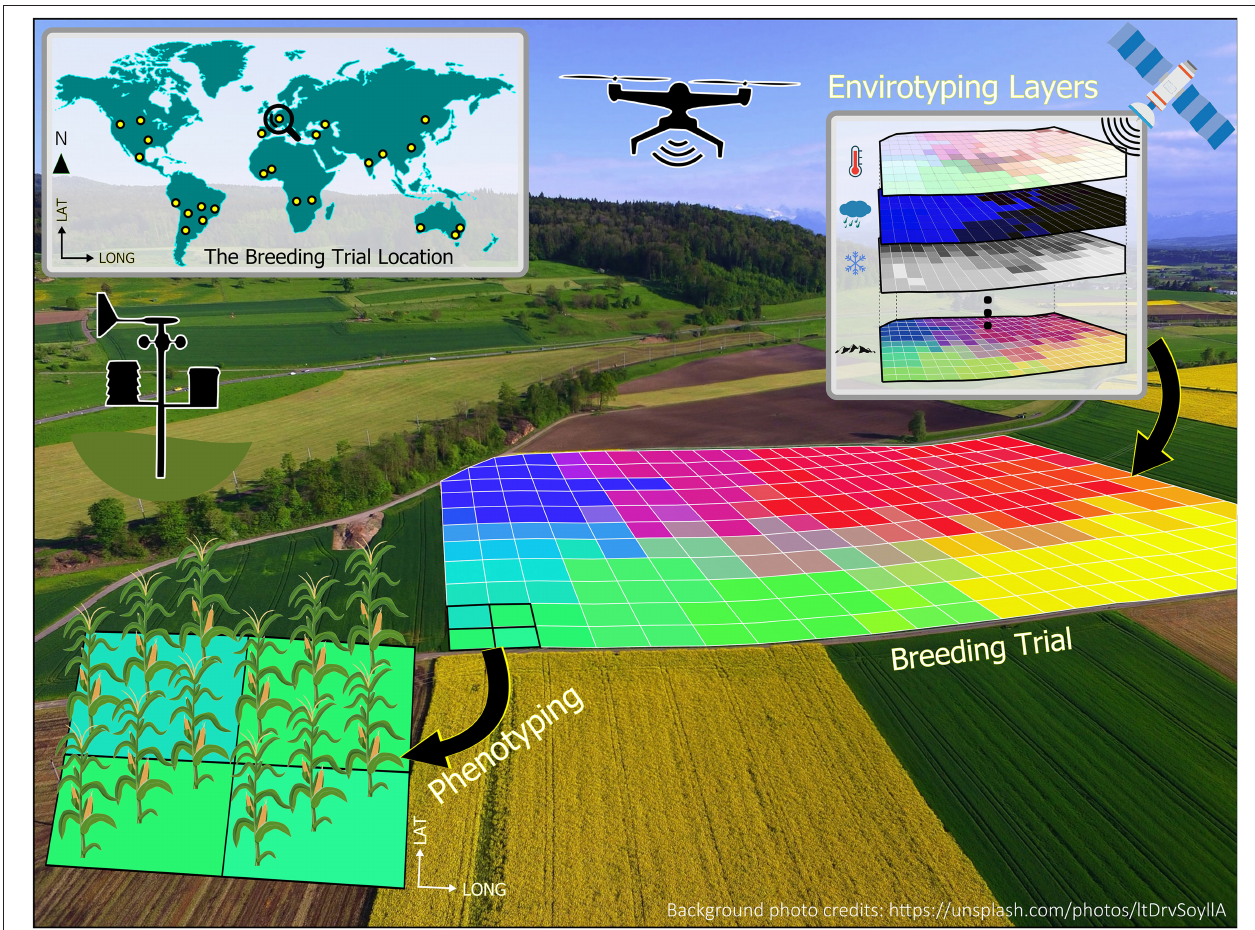
FIGURE 1 | Geoprocessing environment allocated to a breeding trial, containing numerous pixels (i.e., the colored gridded cells) with multiple environmental information (e.g., climate, atmospheric, soil, and landscape) from diverse sources such as weather stations, orbital satellites, and drones. Each pixel may contain information obtained by envirotyping, phenotyping, and